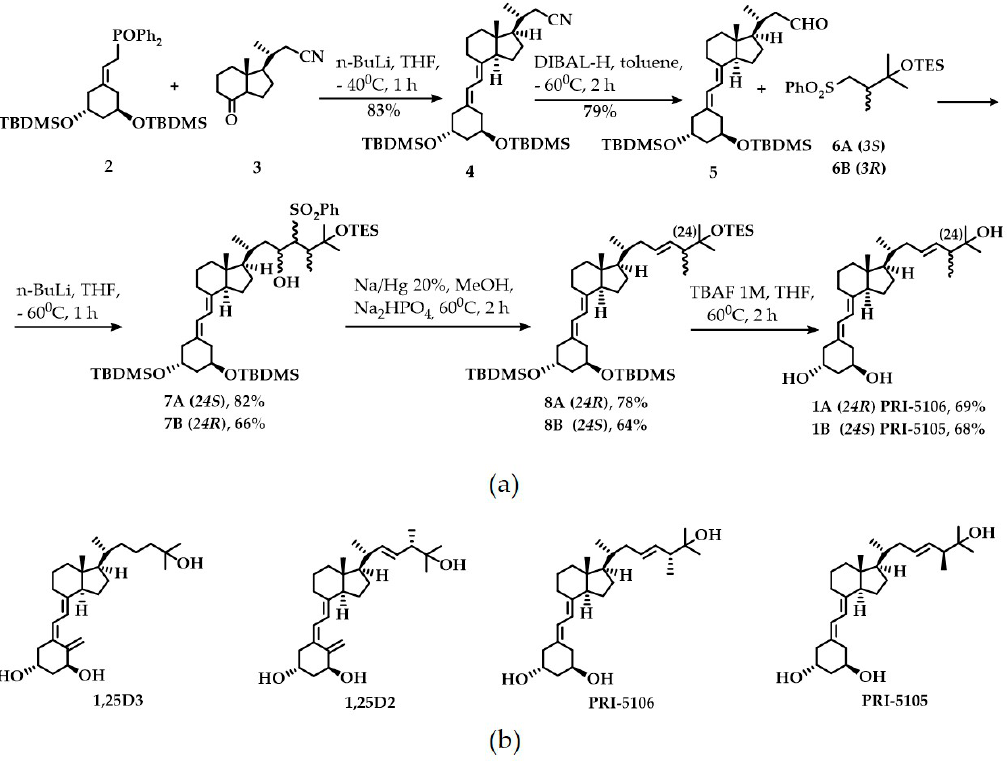
Figure 1. Synthesis and structures of the vitamin D derivatives (VDDs) studied. ( a ) Synthesis of VDDs of 1,25D2: PRI-5106 ( 1A ) and PRI-5105 ( 1B ); ( b ) Structures of 1,25-dihydroxyvitamin D 3 (1,25D3) and 1,25-dihydroxyvitamin D 2 (1,25D2) as well as (24 R )-1,25-dihydroxy-19- nor -20a-homo-ergocalciferol (PRI-5106) and (24 S )-1,25-dihydroxy-19- nor -20a-homo-ergocalciferol (PRI-5105).